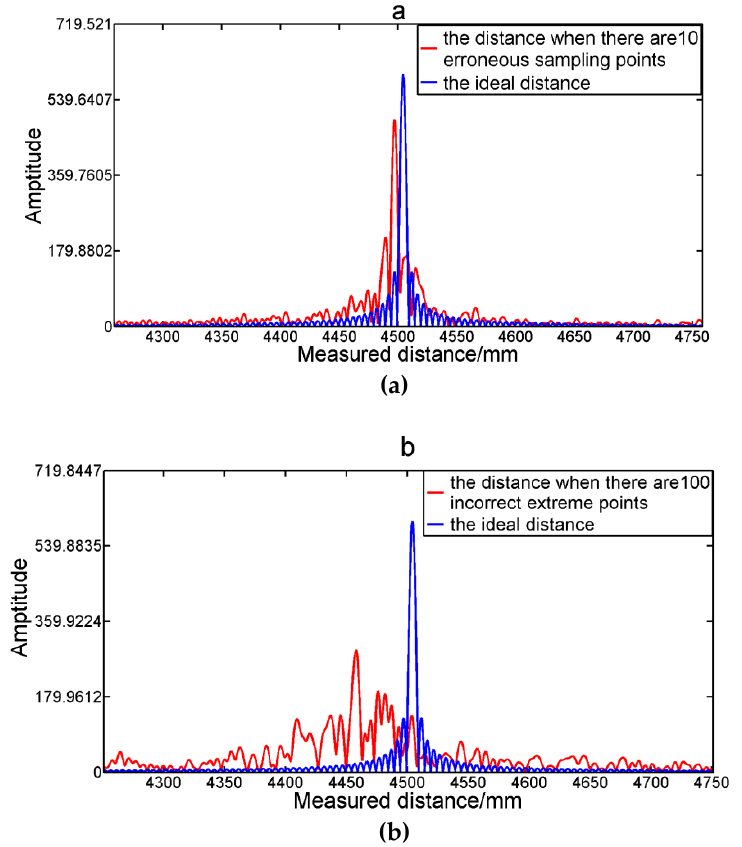
Figure 3. ( a ) The simulation result of 10 erroneous sampling points on accuracy when the ideal value of P is 9000 and N is 60,000. ( b ) The simulation result of 100 erroneous sampling points on accuracy when the ideal value of P is 9000 and N is 60,000.